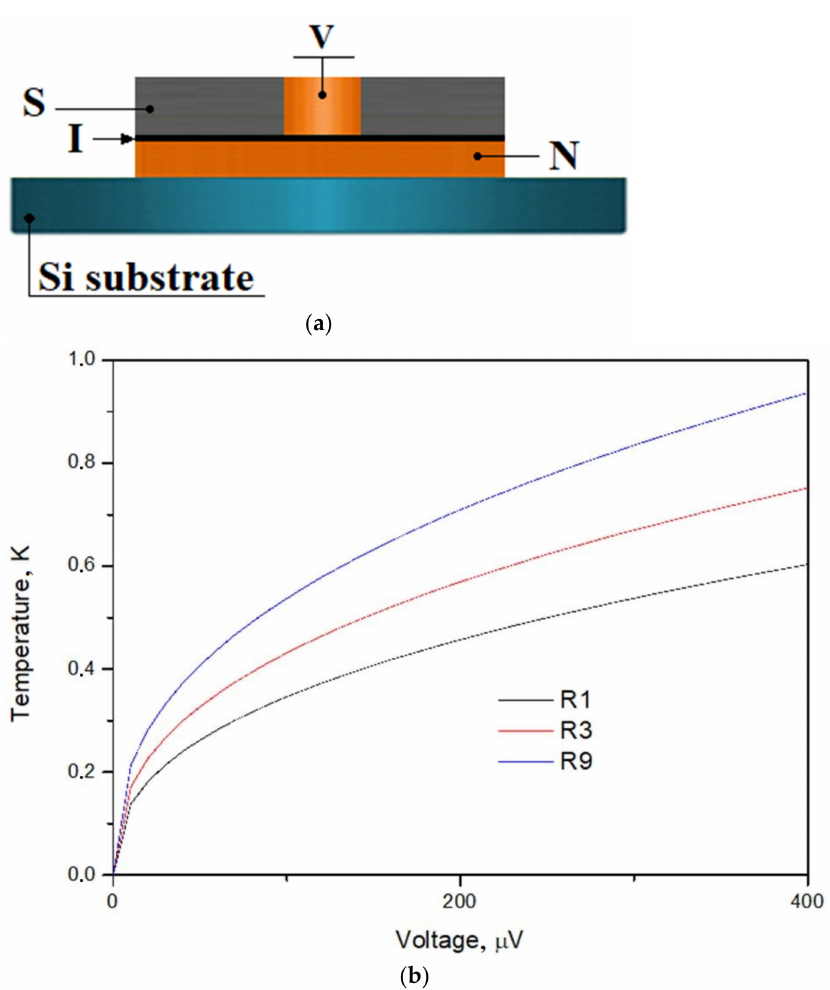
Figure 7. ( a ) Schematic view of NIS junction of 1 × 1 µ m in size with 0.2 µ m flux kernel, here: N— normal metal film; S—superconducting electrode; I—insulator; V—normal kern of single Abrikosov’s Vortex forming NIN tunnel junction shunting NIS junction; ( b ) addition to electron temperature due to overheating through 1, 3, 9 NIN